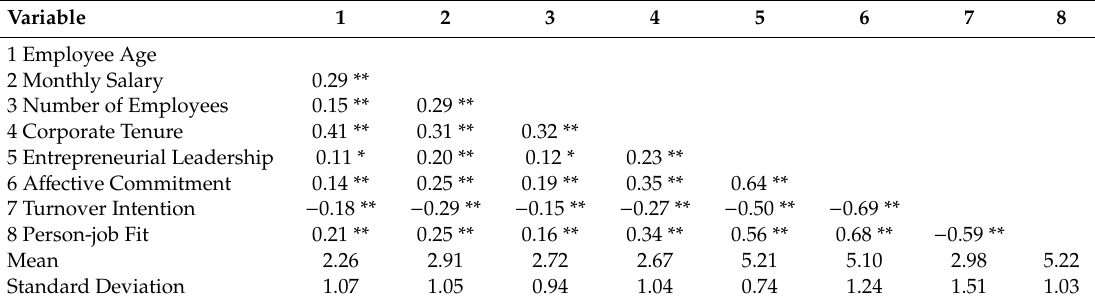
Table 2. Descriptive statistics and correlations for the main variables.